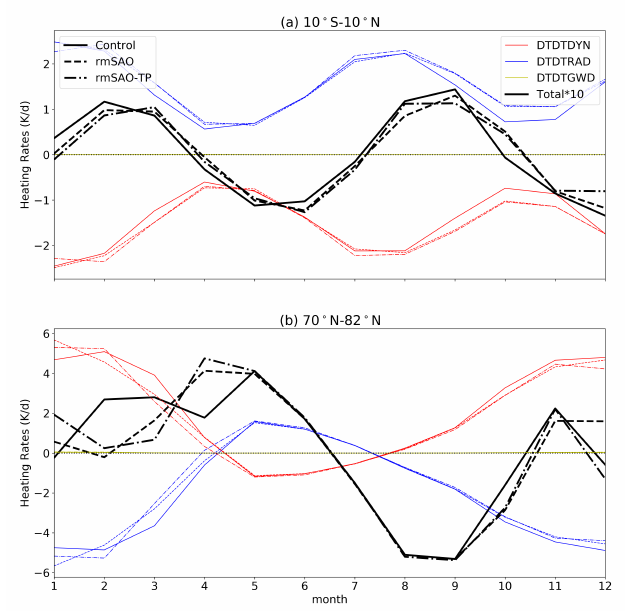
Figure 11. Annual cycle of the heating rates at 2 hPa on average around the tropical region (10 ◦ S– 10 ◦ N) ( a ), the NH high latitudes (70 ◦ S–82 ◦ S) ( b ). The red, blue and yellow lines indicate the heating rates related to dynamics (DTDTDYN), radiation (DTDTRAD) and GWD processes (DTDTGWD), respectively. The total heating rates, which are the sum of the dynamical, radiative and GWD heating rates, are illustrated by black lines. The solid, dashed and dotted-dashed lines indicate data from the control, rmSAO and rmSAO-TP simulations, respectively.